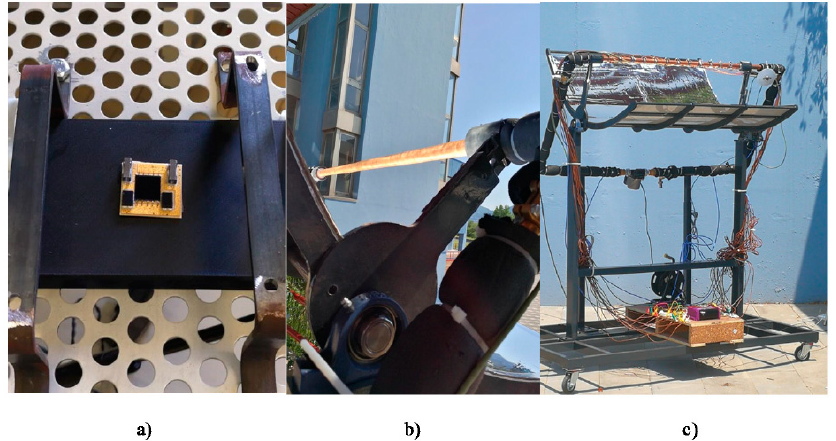
Figure 1. Experimental plant: ( a ) triple-junction solar cell; ( b ) cooling fluid circuit; ( c ) line-focus concentrating photovoltaic and thermal (CPV/T) system.